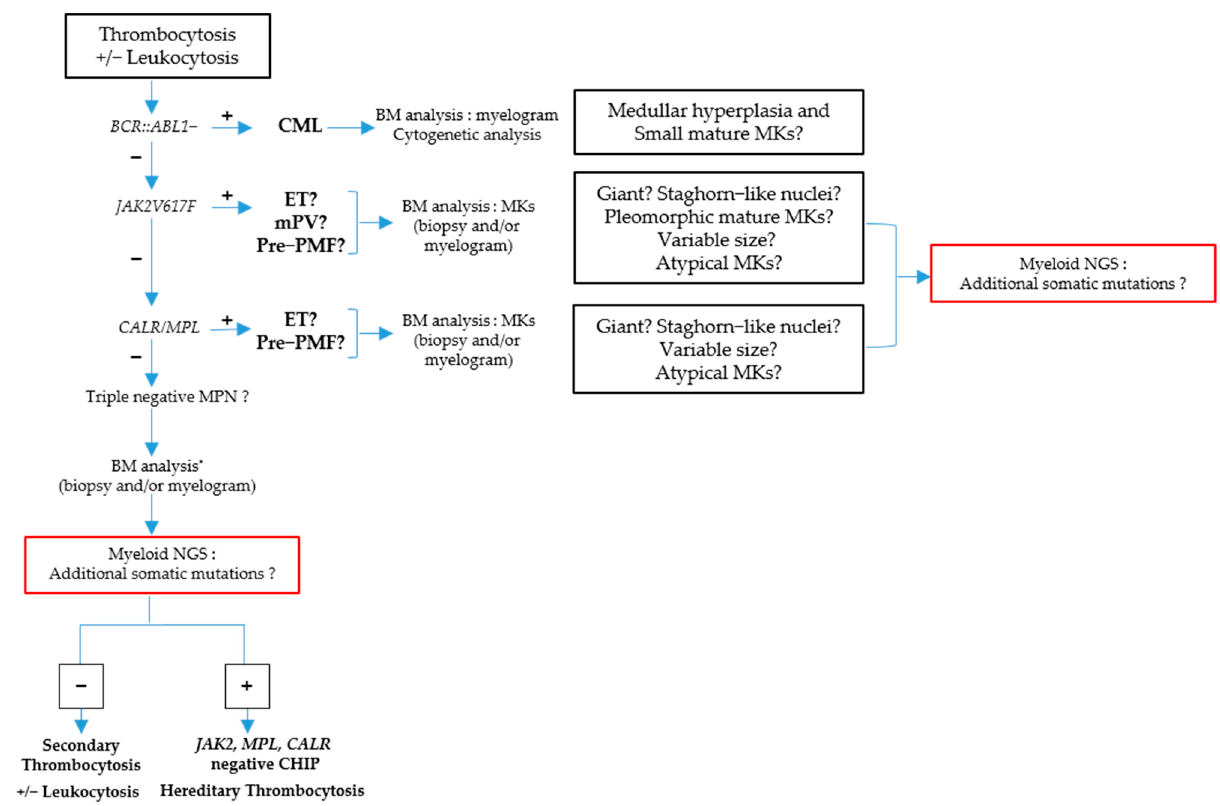
Figure 8. Algorithm diagnosis for CML, ET, prePMF.